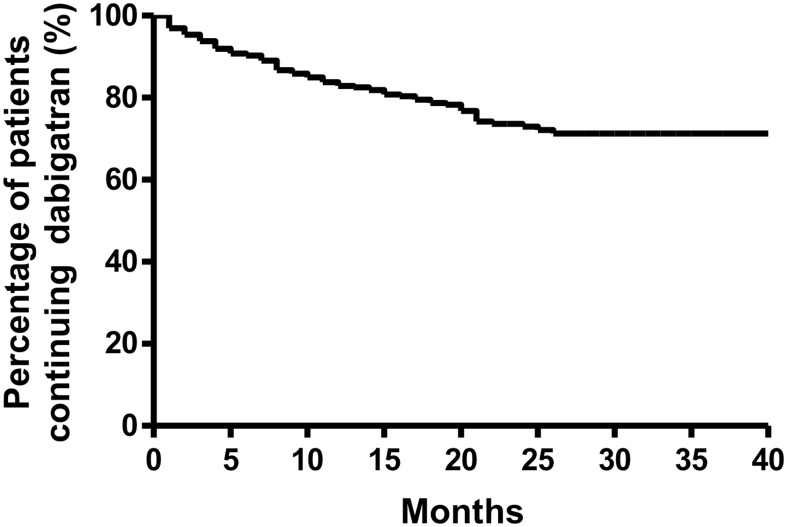
Kaplan Meier analysis of drug discontinuation rate.